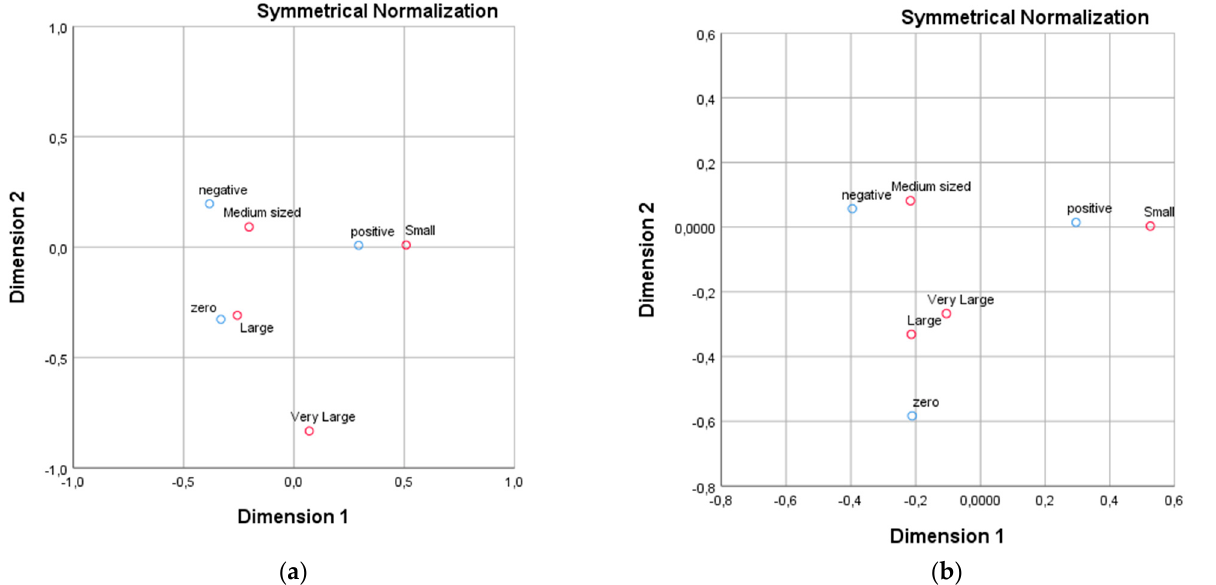
Table 2. Chi-square test (firm size vs. discretionary accruals).